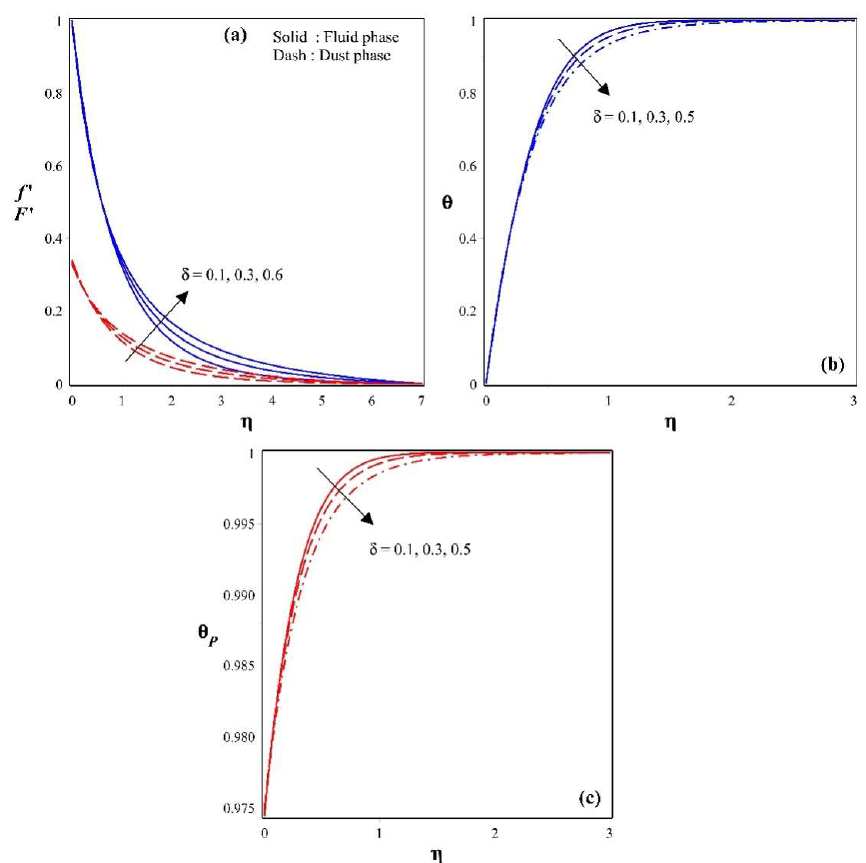
Figure 3. ( a ): Impact of the curvature parameter on the fluid-phase velocity f (cid:48) and dust-phase velocity F (cid:48) profiles; ( b ): effect of the curvature parameter on the fluid-phase temperature profile; and ( c ):effect of the curvature parameter on the dust-phase temperature profile.